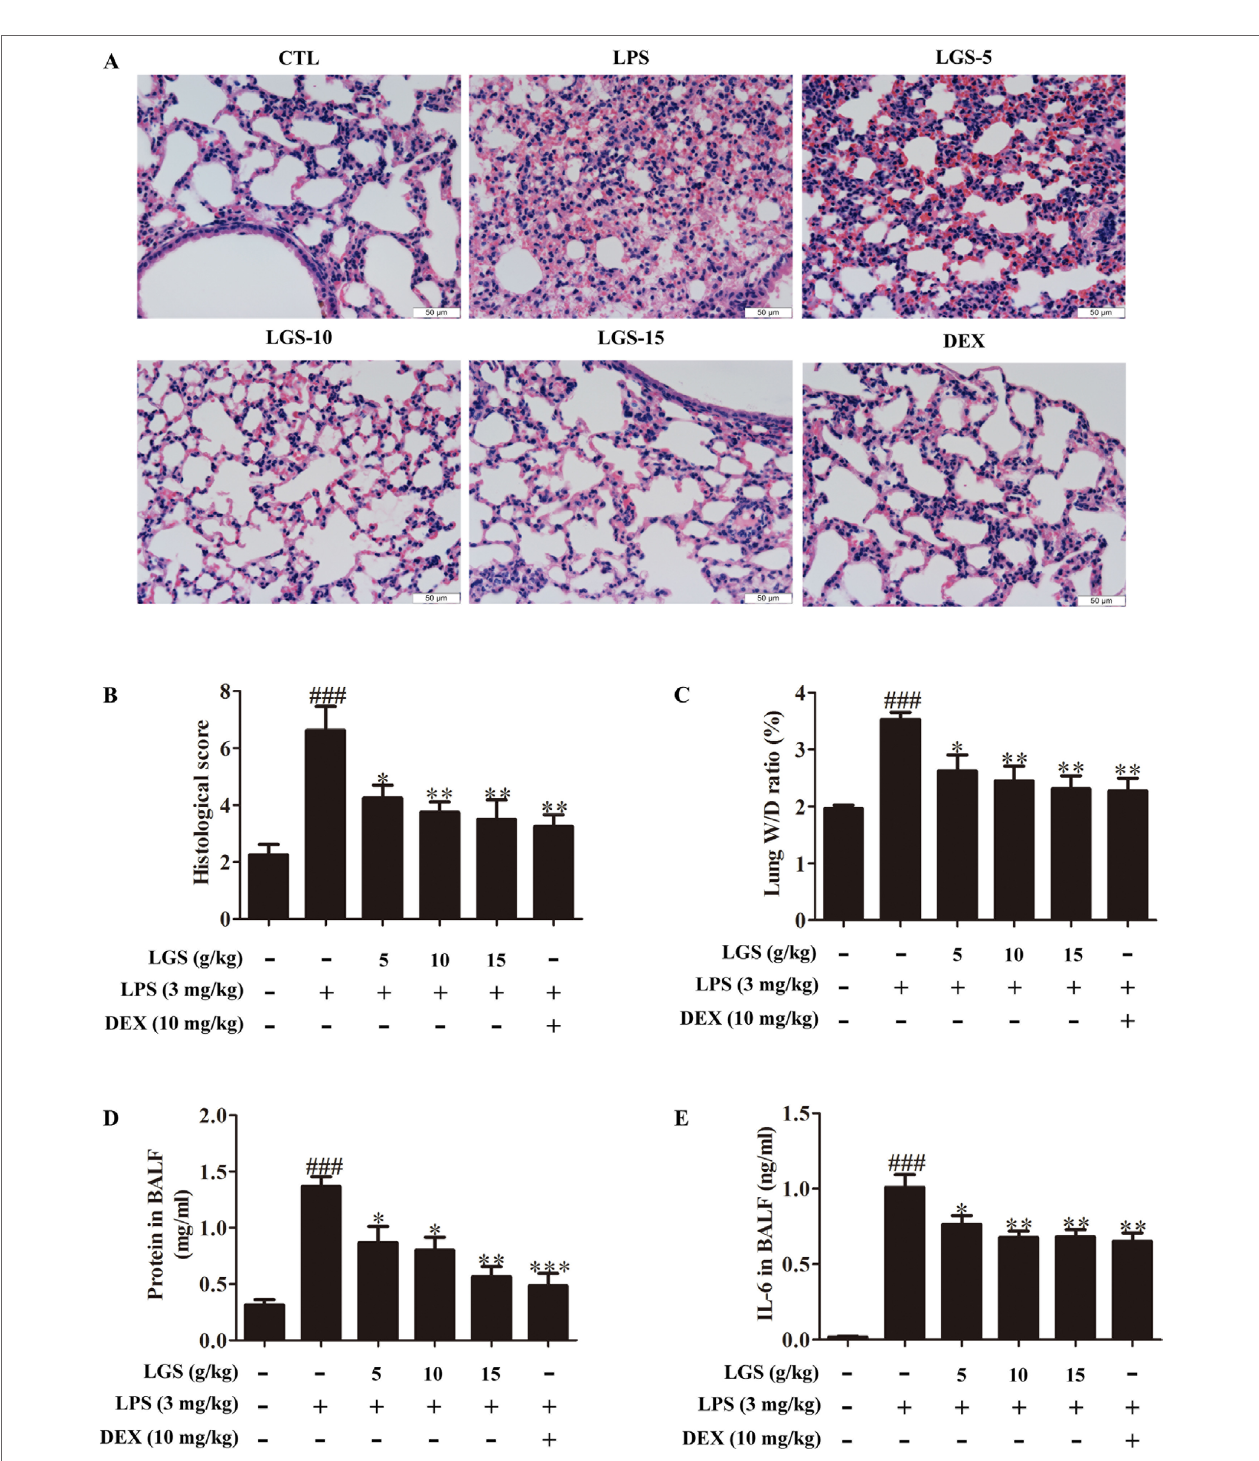
FIGURe 6 | LGS attenuates acute lung injury in mice. After being intragastric administered with LGS (5 g/kg, 10 g/kg, 15 g/kg) or DEX (10 mg/kg) for 7 days, respectively. LPS (3 mg/kg) was intratracheally instilled to induce the ALI model. The mice were anesthetized with 1.5% ( w / v ) pentobarbital sodium solution to acquire bronchoalveolar lavage fluid (BALF) samples and lung tissues. (A−B) LGS ameliorates the pathological changes in ALI mice. After H & E staining, the tissue sections were observed ( A , 400 ×) and the histological score were estimated (B) . (C−D) LGS decreases the capillary permeability of lung tissues in ALI mice. (C) Lung W/D ratio was detected by electronic scales (D) and the protein content in BALF was measured by BCA assay. (e) LGS decreases inflammation of lung tissues in ALI mice. The level of IL-6 in BALF was determined by ELISA. Data are represented as the mean ± SEM. ### P < 0.001 versus control, * P < 0.05, ** P < 0.01 and *** P < 0.001 versus LPS treatment by one-way ANOVA with Tukey’s test.